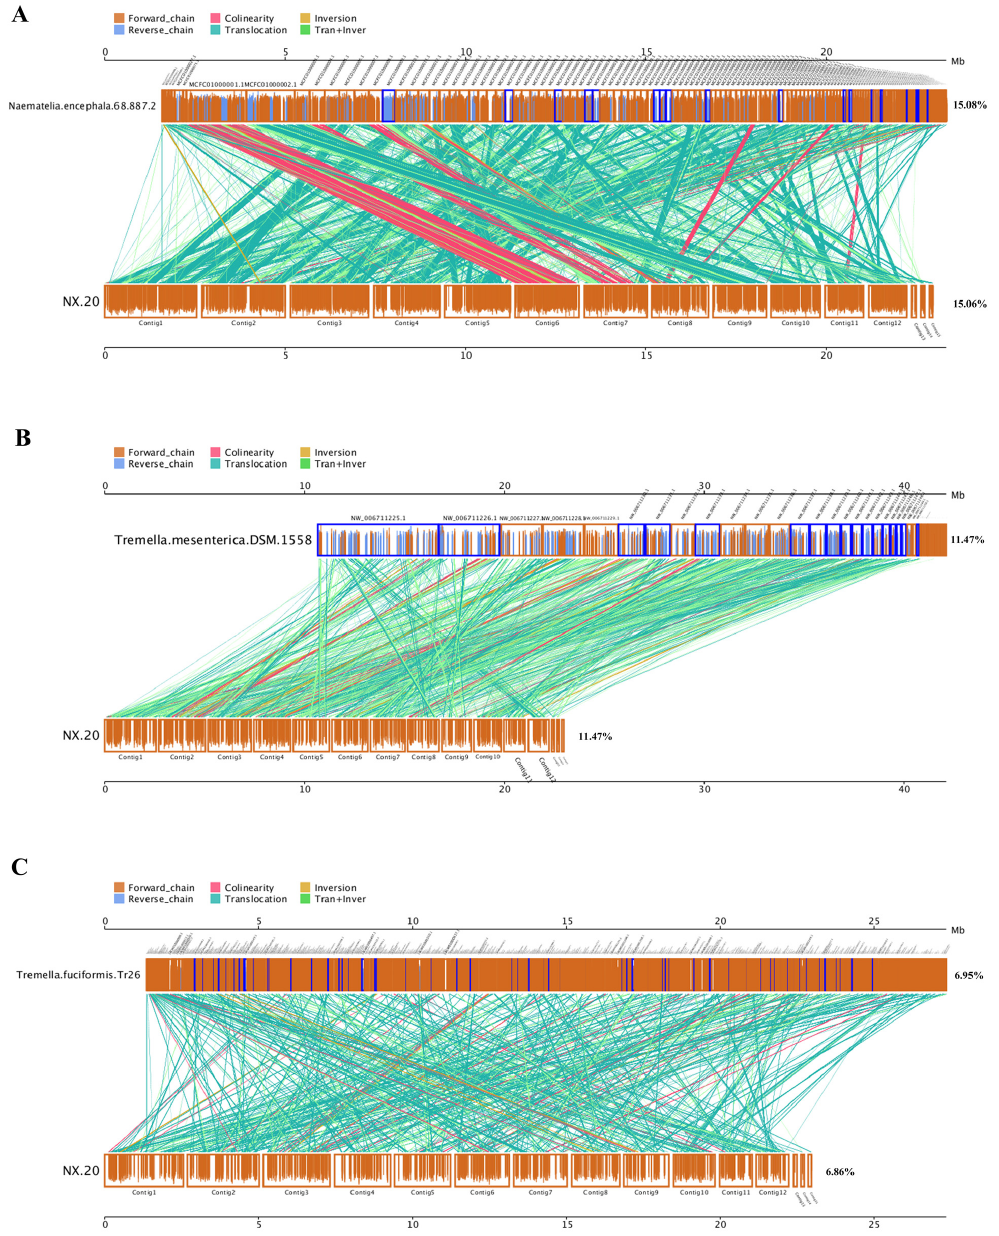
Figure 4. Synteny of N. aurantialba NX ‐ 20 with N. encephala 68 ‐ 887.2 ( A ), T. mesenterica DSM 1558 ( B ), and Tremella fuciformis Tr26 ( C ). The upper axis indicates the genome measured, and the lower axis indicates the reference sequence genome. The forward and reverse strands are represented by yellow boxes and blue boxes, respectively. The height of the filled color in the box indicates the similarity of the alignment, and full filling indicates 100% similarity. The color of the linked graph between the upper and lower axes indicates the alignment type: Collinear, syntenic alignment; Translocation, translocation alignment; Inversion, inverted alignment; Tran + inver, alignment of translocations and